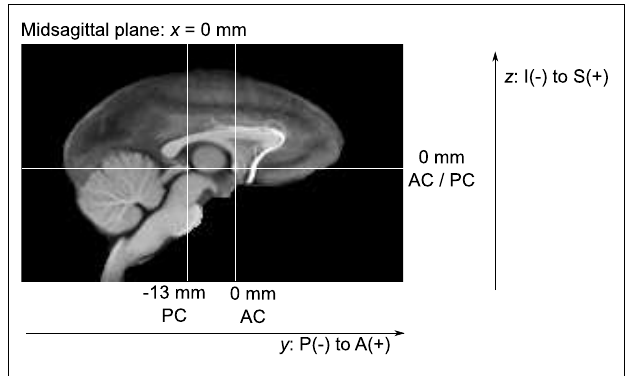
FIGURE 5 | Coordinate system defined by theAC and PC landmarks in the midsagittal plane (x =